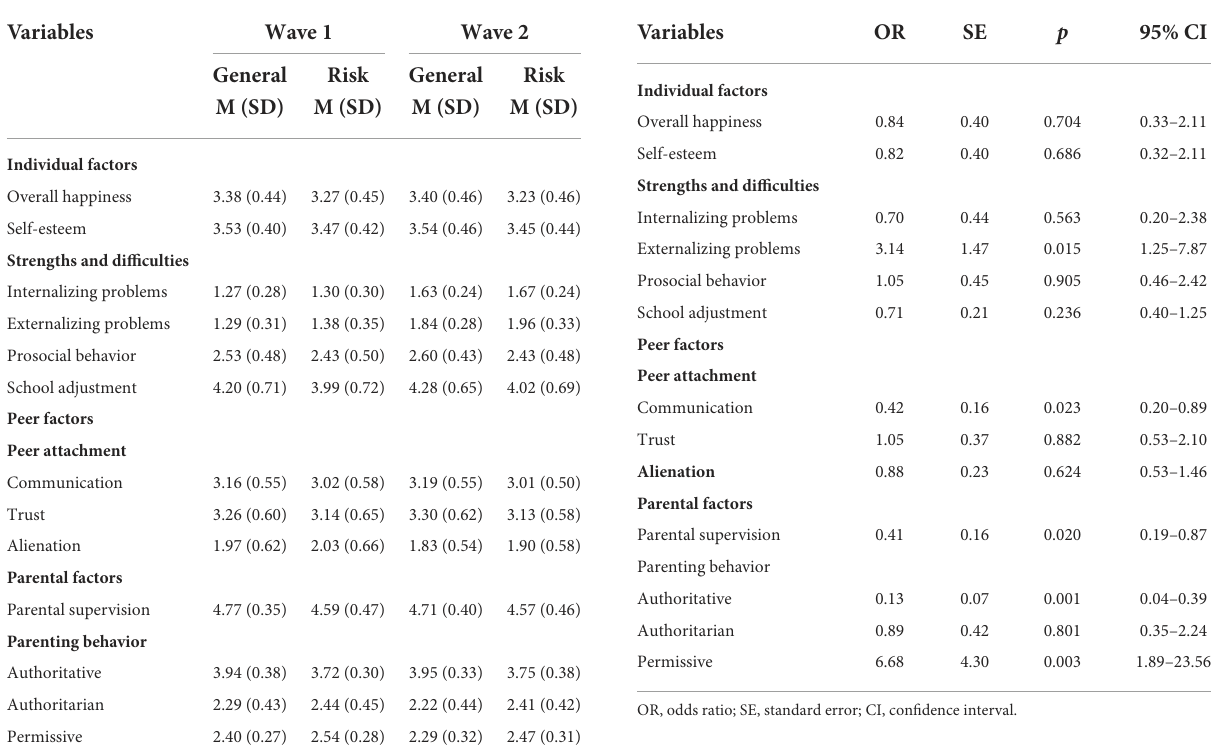
TABLE 2 Differences in variables between the general and high-risk groups ( N = 342).